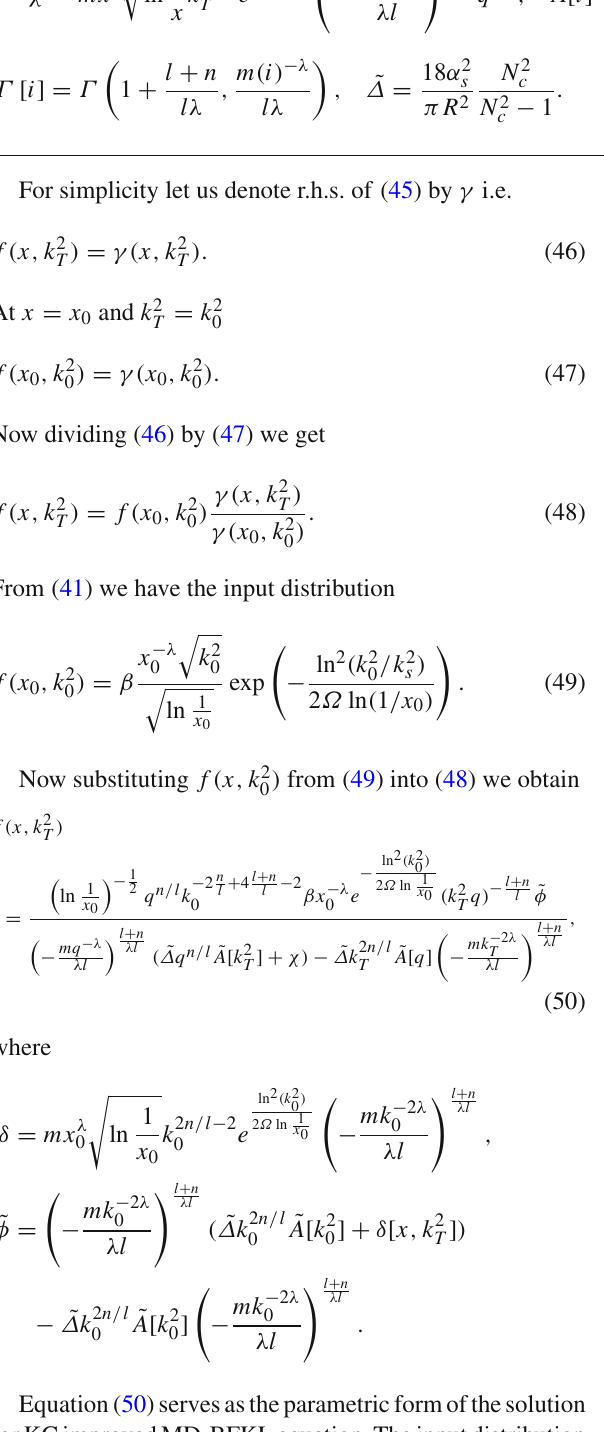
Fig. 9 Three dimensional representation of a TMDlib HERA data fit: PB-NLO-HERAI+II+2018 (left), b our solution for KC improved MD- BFKL in x - k 2 phase space T